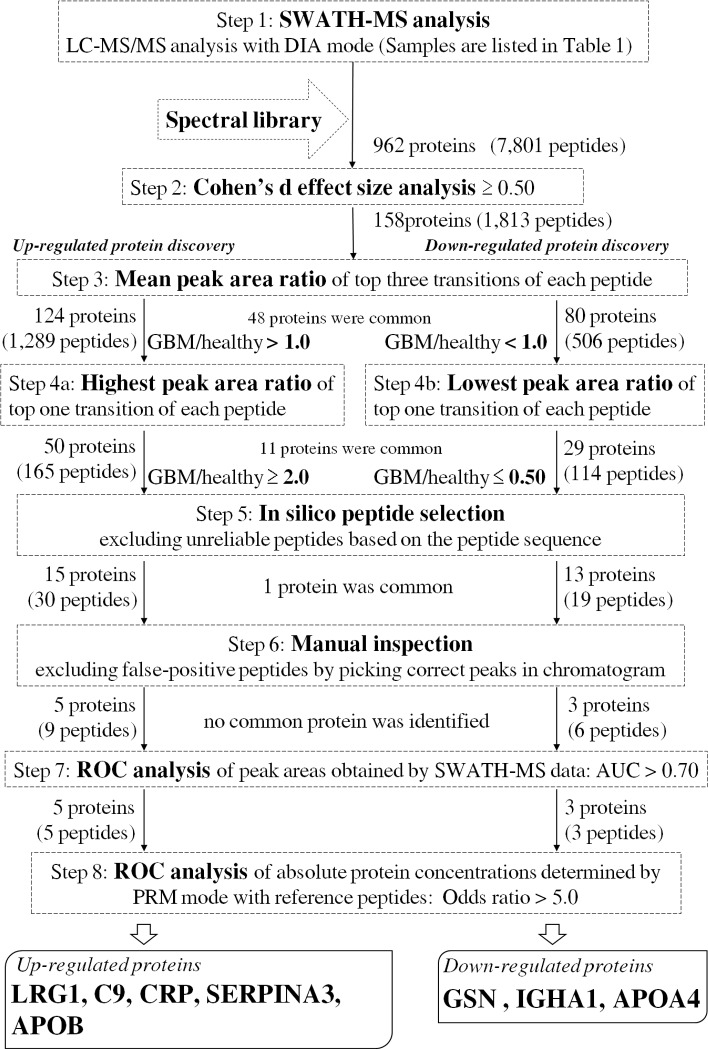
Flow diagram of GBM biomarker discovery.